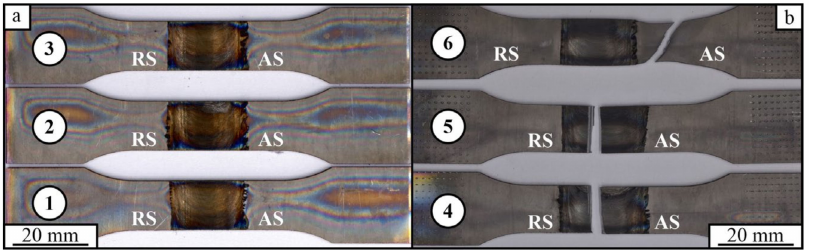
Figure 13. The tensile samples cut off the FSW welds obtained at tool rotation rates 340 (1 and 4), 360 (2 and 5) and 380 (3 and 6) RPM before ( a ) and after ( b ) the tensile